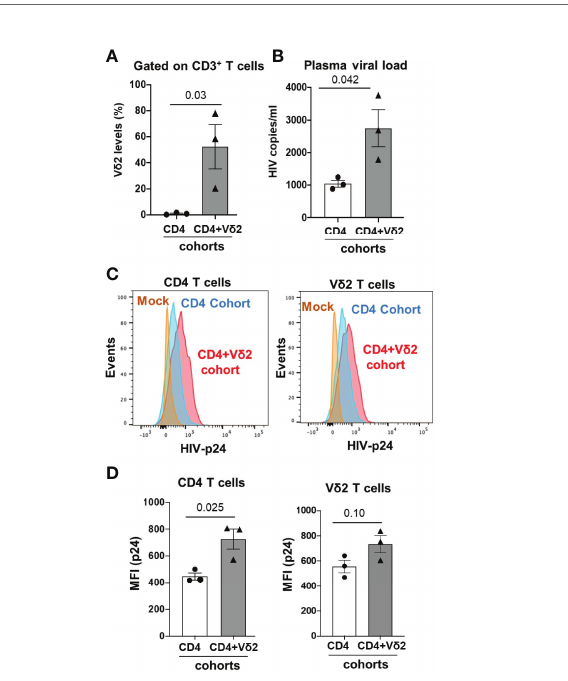
FIGURE 7 | Adoptive transfer of V d 2 T cells increases HIV replication in cell- associated HIV transmission in BLT huMice. (A) V d 2 cell number signi fi cantly increased 2-weeks post-adoptive transfer in peripheral blood of BLT huMice (n = 3 biological replicates per group); analyzed by fl ow cytometry. (B) HIV viral load increased signi fi cantly in plasma of V d 2+CD4-engrafted BLT huMice compared to CD4-engrafted BLT huMice; measured via qPCR at two weeks post-adoptive transfer (n = 3 biological replicates per group). (C) Representative fl ow cytometry histogram plots of peripheral blood total CD4 + T cells and V d 2 cells expressing HIV p24 respectively. (D) HIV p24 is slightly higher in peripheral blood total CD4 + T cells and V d 2 T cells of BLT huMice that received CD4+V d 2 treatment compared to the BLT huMice that received only CD4 + T cells treatment respectively (n = 3 biological replicates per group). Data are presented as mean values ± SEM. P values were determined using a two-tailed paired t- test within the treatment groups.